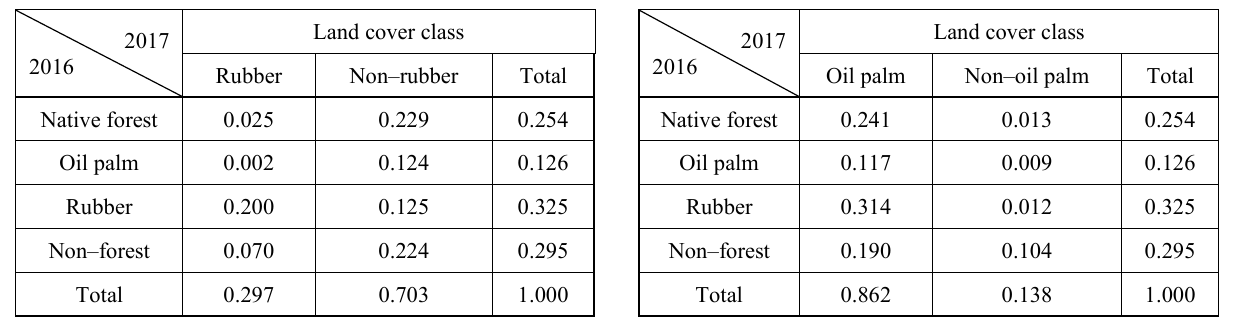
Table 2. Rubber occurrence probability in 2016. Table 3. Oil palm occurrence probability in